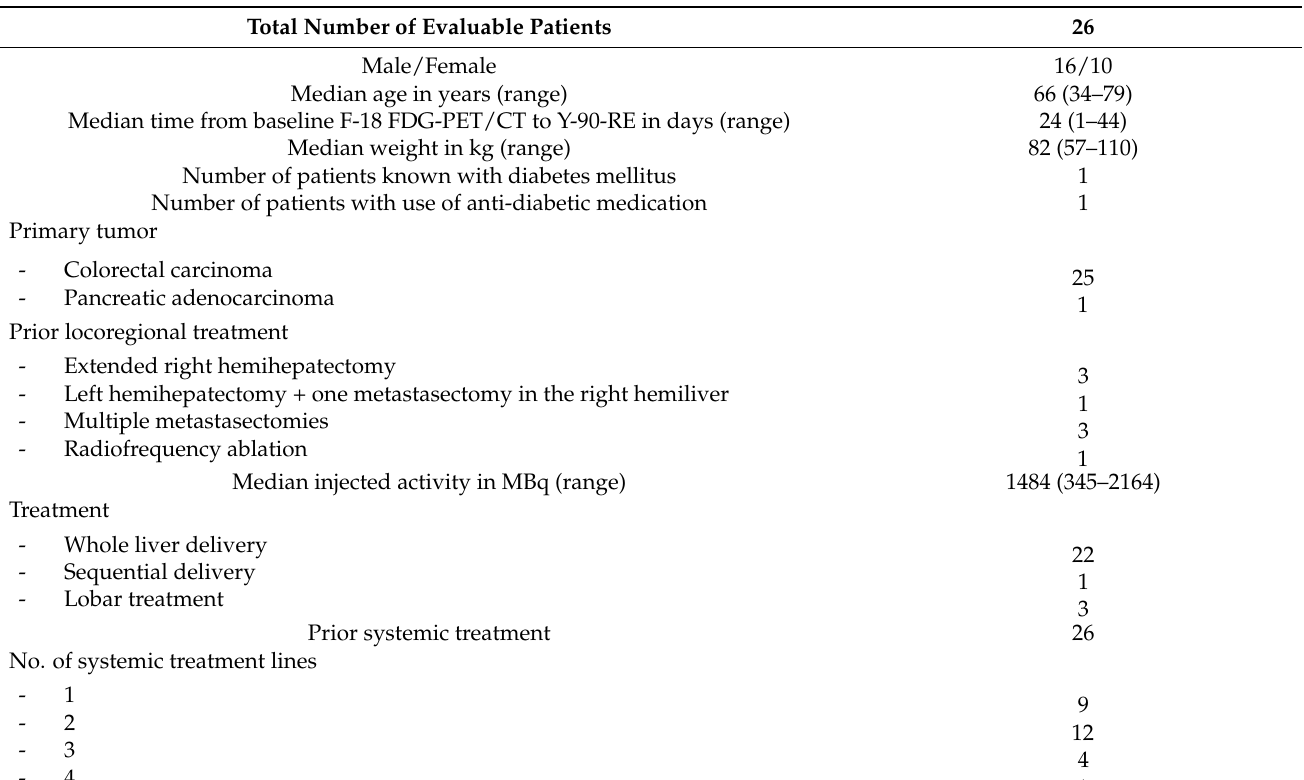
Table 1. Baseline characteristics of the included patients.